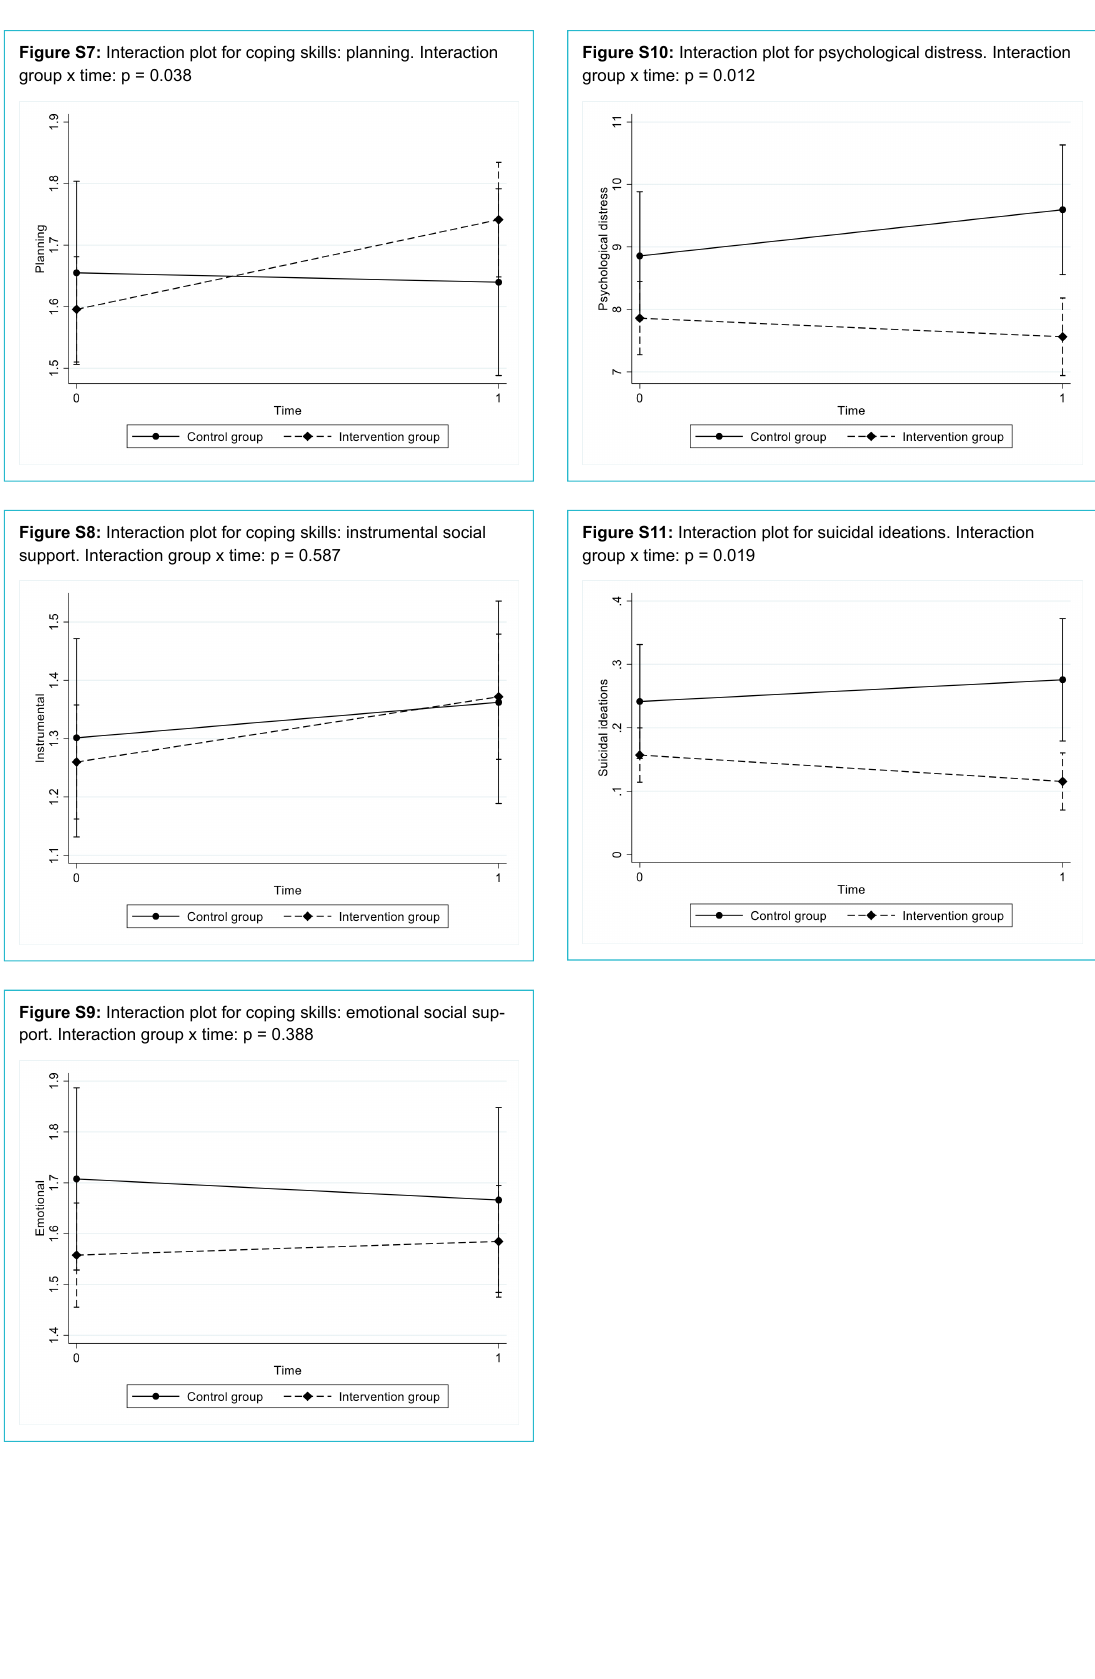
Figure S10: Interaction plot for psychological distress. Interaction group x time: p = 0.012